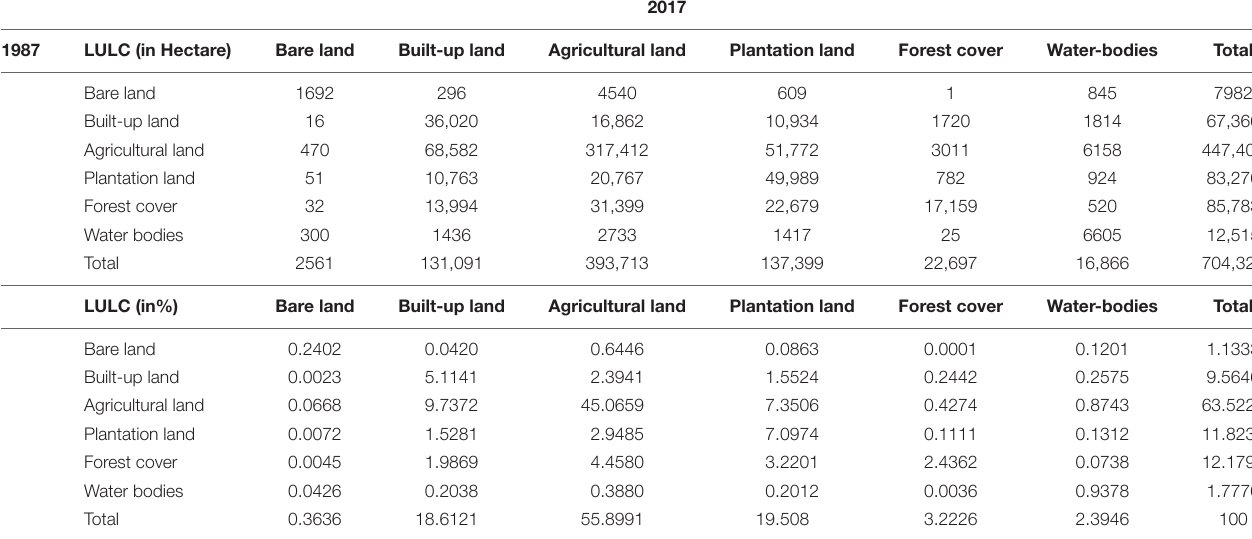
TABLE 2 | Change detection matrix of land use and cover,